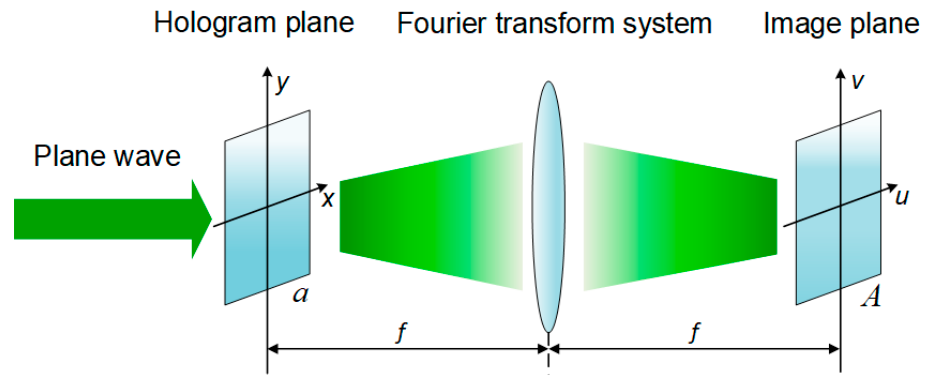
Figure 1. Schematic geometry for optical Fourier transform system: the hologram plane is located in the front focal plane of the Fourier lens, and the image plane is located in the back focal plane of the Fourier lens.